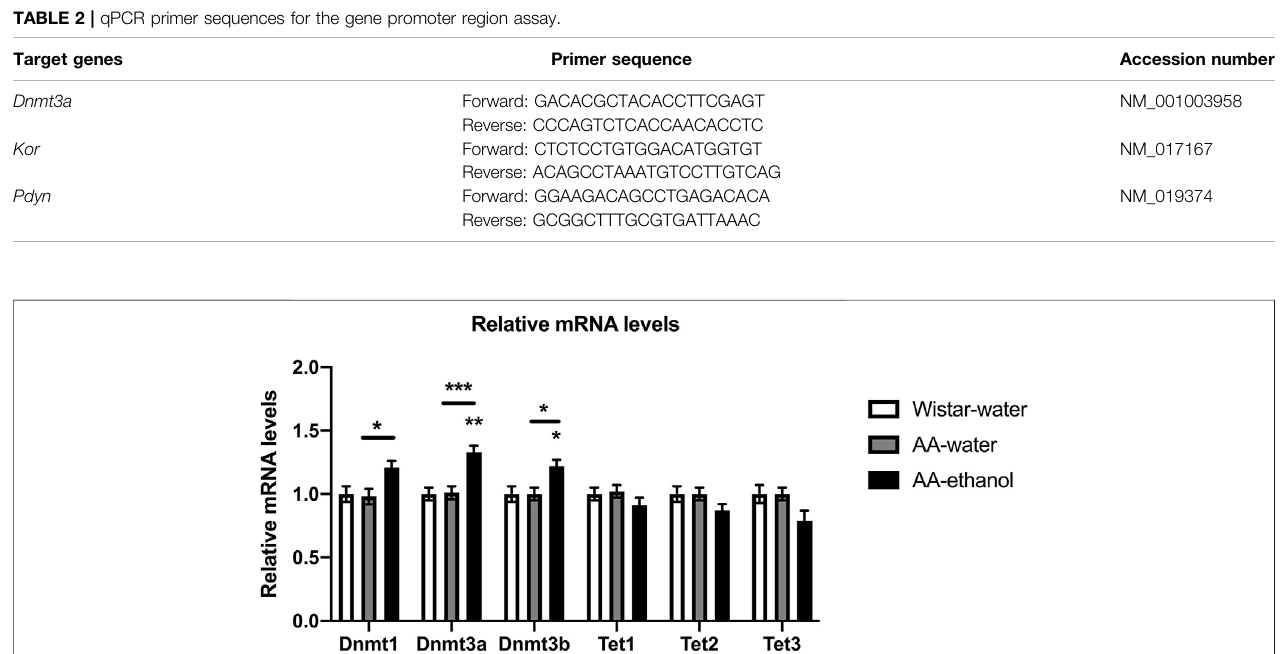
FIGURE 1 | Impact of intermittent alcohol exposureon Dnmt1, Dnmt3a, Dnmt3b, Tet1, Tet2, and Tet3 expression levels in the NAc. One-way ANOVA followed by Tukey ’ s multiple comparisons test; *** p < 0.001, ** p < 0.01, * p < 0.05 compared with the Wistar-water group; n (cid:2) 5 – 7. Error bars indicate SEM.